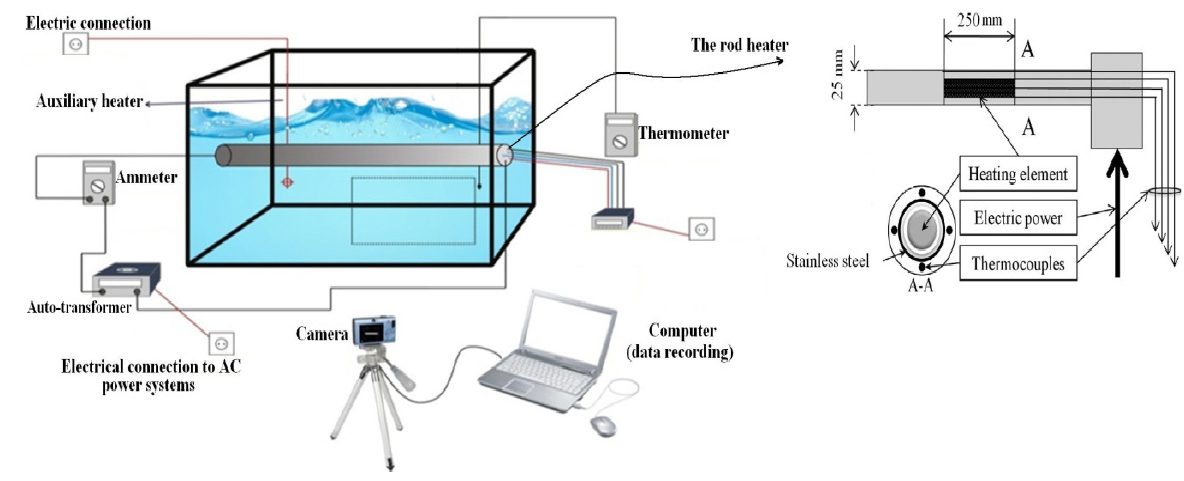
Figure 1: Overview of the pool boiling heat transfer